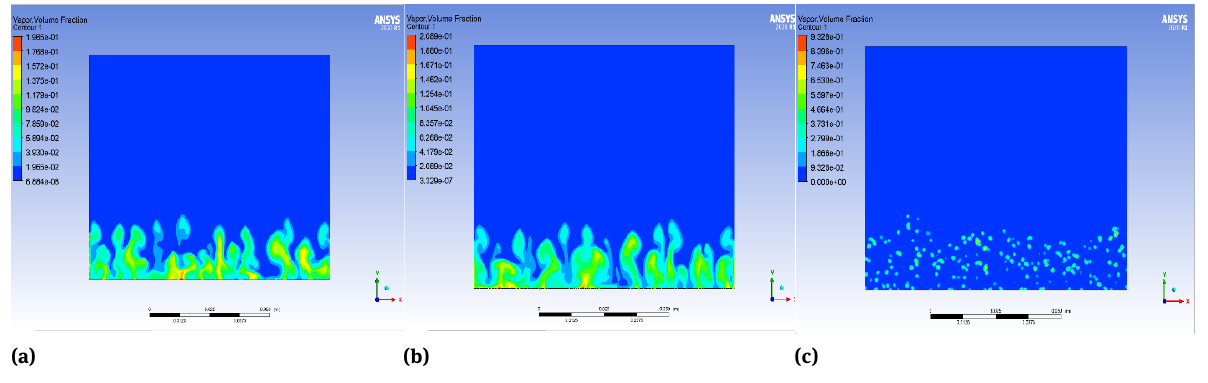
Figure 3: Volume fraction in 1 s. (a) Eulerian; (b) mixture; (c) VOF